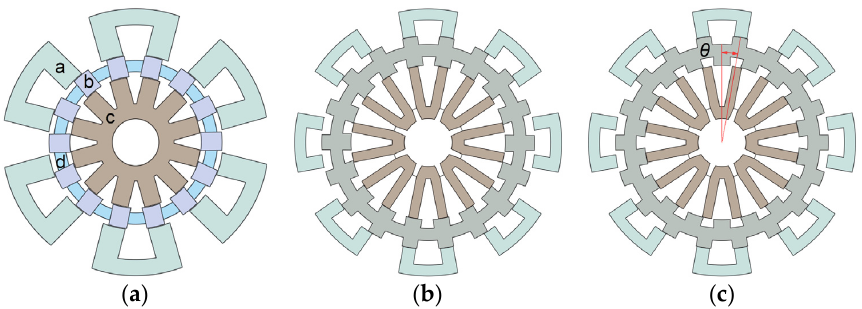
Figure 20. ( a ) 12/14/12 double-stator SRM with segmental outer stators and rotors where “a” and “b” are U-shaped segmental stators and segmental rotors, respectively, “c” is inner stator and “d” is non-magnetic isolator; ( b , c ) are proposed 16/18/16 double-stator SSRMs with inner and outer segmental stators without non-offset and with offset rotors.